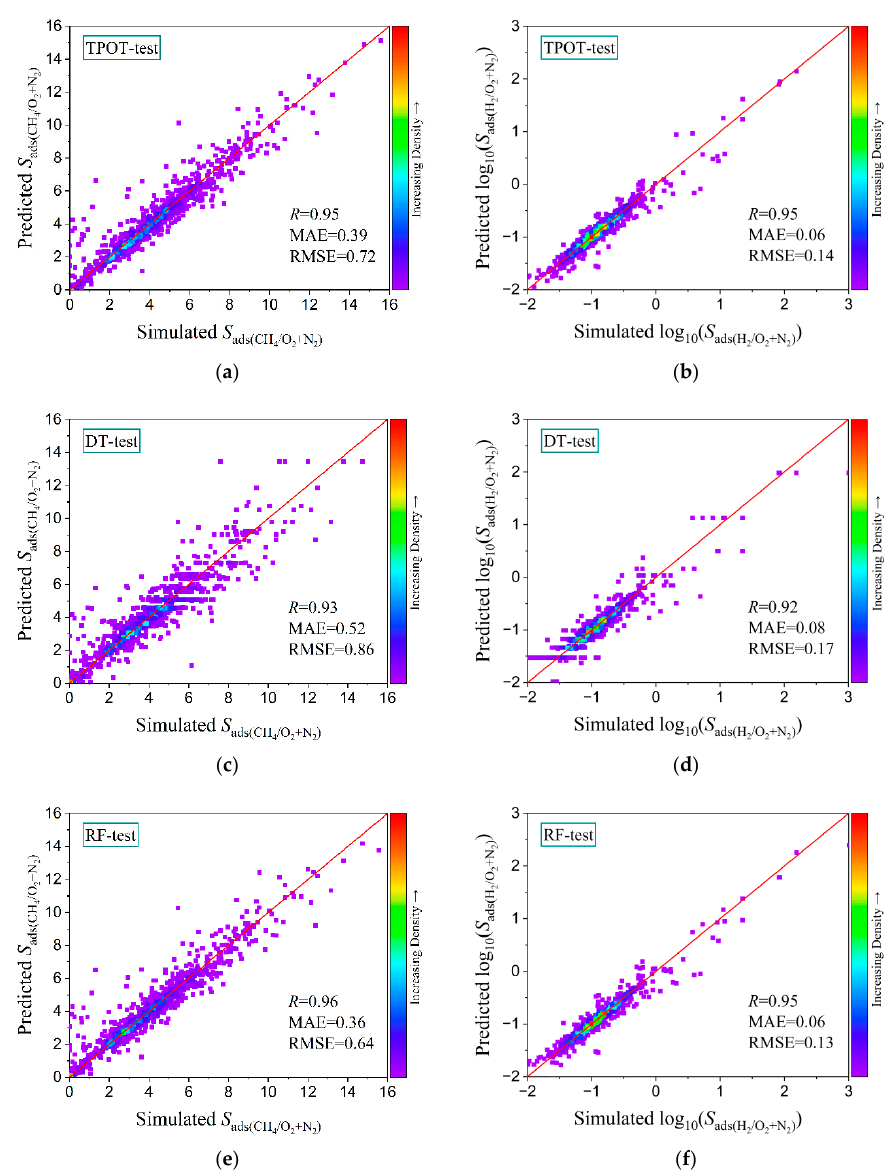
Figure 3. S ads(CH4/O2+N2) and log 10 ( S ads(H2/O2+N2) ) predicted by three ML methods: ( a , b ) TPOT; ( c , d ) DT; and ( e , f ) RF versus the simulated values on the test set.